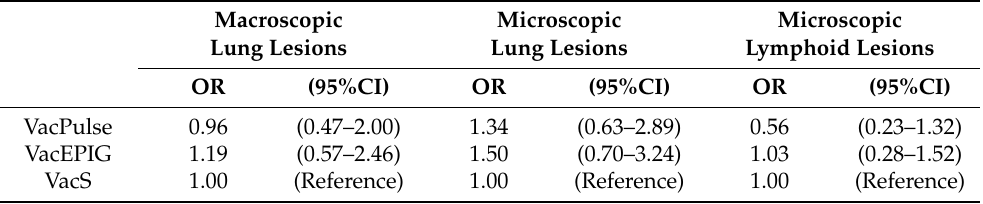
Table 4. Odds ratio (OR) and 95% confidence intervals (CI) for pathological